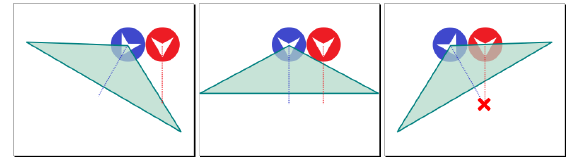
necessary to perform s different renderings (one for each slice) (Lines 2 to 11) adjusting the viewport (Line 4) and the frustum (Lines 6 to 9) for each one of them. All the slices are rendered within different viewports in the same image (Line 10). The function called at the Line 10 works the same way as in the original models, but here it is called once for each slice. Finally, the functions in lines 12 and 14 are executed the same way as in the original models. Algorithm 1 Panoramic vision implementation.